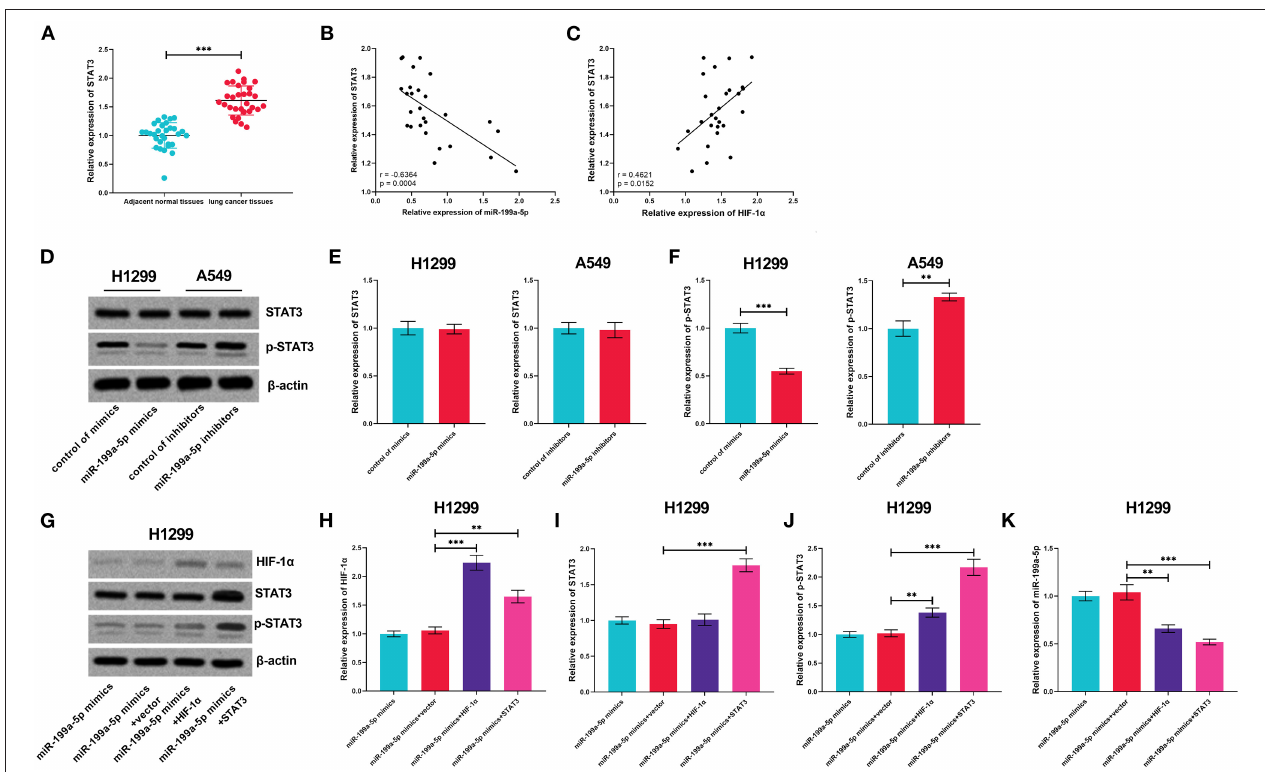
FIGURE 6 | The positive feedback loop was found among miR-199a-5p, HIF-1 α , and STAT3. (A) Expression of STAT3 in 30 pairs of adjacent normal lung tissues and NSCLC tissues was detected by qRT-PCR. (B,C) Correlation between STAT3 expression and miR-199a-5p expression or HIF-1 α expression in NSCLC tissues. (D–F) Western blotting was used to detect STAT3, p-STAT3, and HIF-1 α expressions in H1299 and A549 cells after the transfection of miR-199a-5p mimics or miR-199a-5p inhibitors. (G–J) Western blotting was used to measure the expressions of STAT3, p-STAT3, and HIF-1 α in H1299 cells after miR-199a-5p, HIF-1 α , and STAT3 were selectively regulated by transfection. (K) qRT-PCR was employed to detect miR-199a-5p expression in H1299 cells after miR-199a-5p, HIF-1 α , and STAT3 were selectively regulated by transfection. All of the experiments were performed in triplicate. ** p < 0.01 and *** p < 0.001,